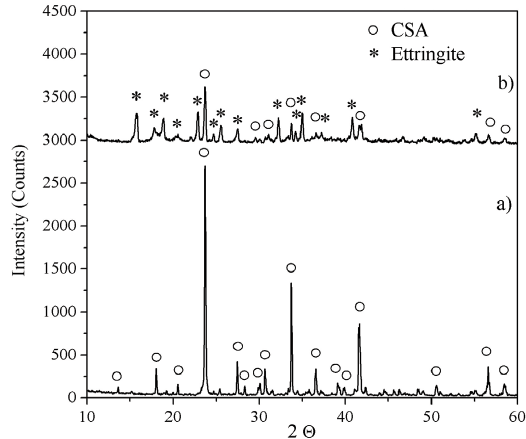
Figure 1. XRD patterns corresponding to the CSA clinker (a) and to the cement after hydration